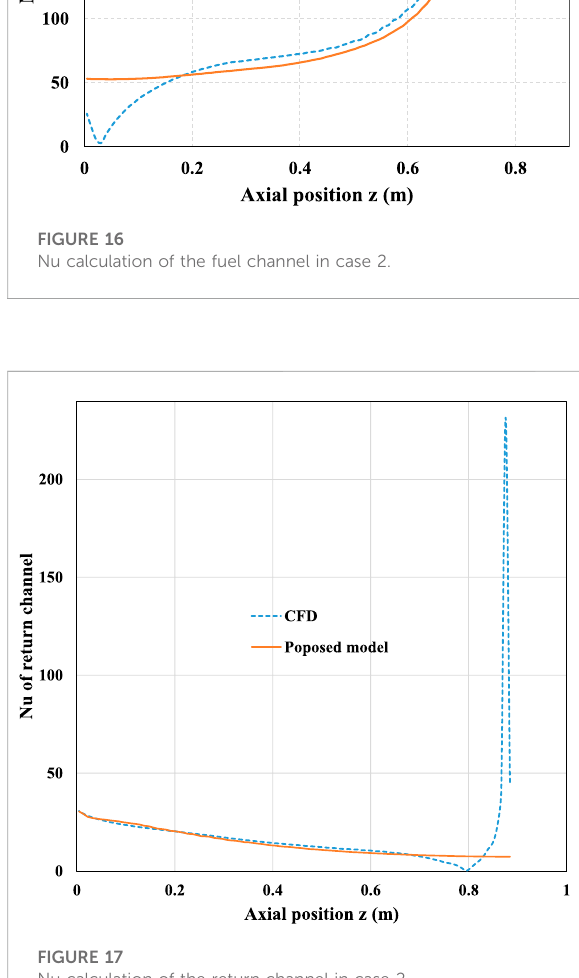
FIGURE 17 Nu calculation of the return channel in case